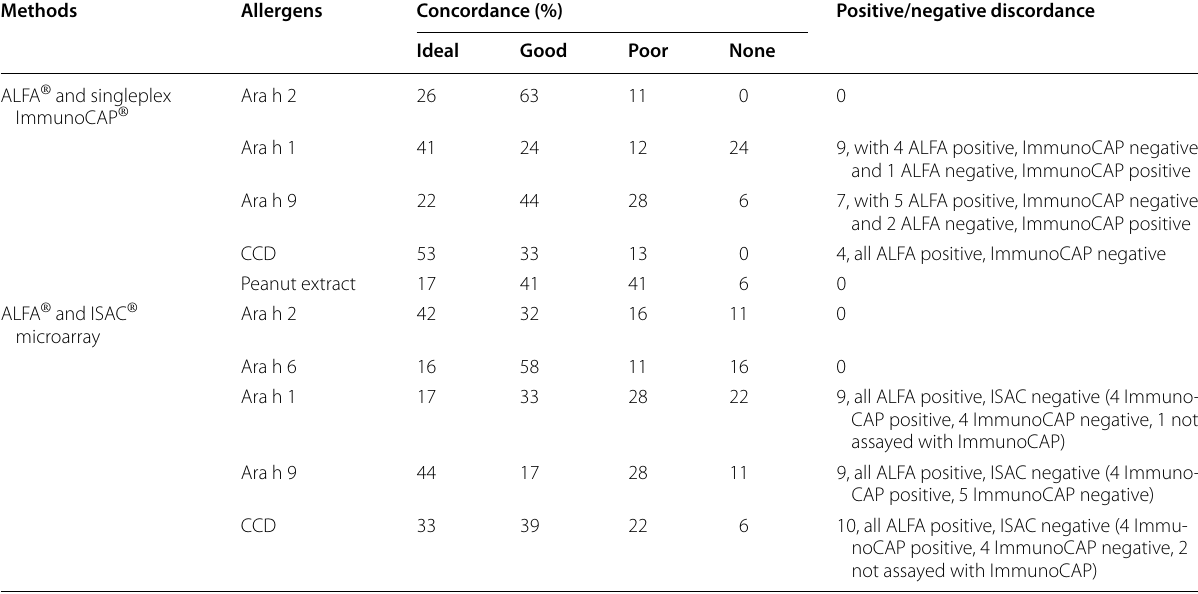
Table 4 Comparison of peanut allergen sIgE measured with three methods: ALFA, ImmunoCAP ® , ISAC ®